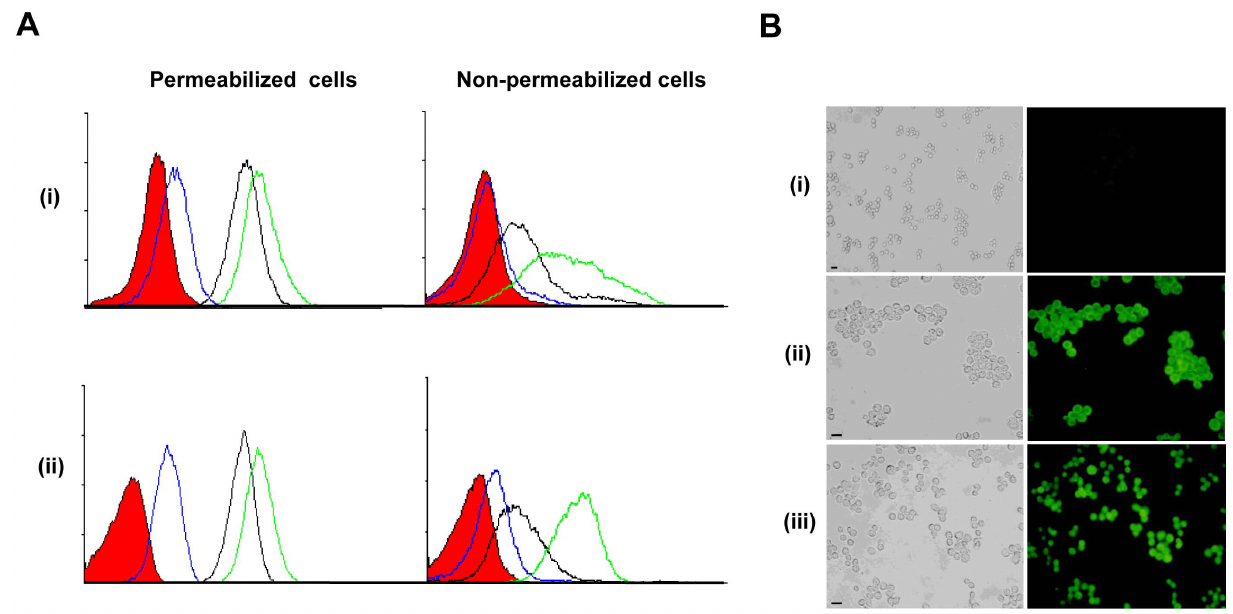
Figure 8. Reactivity of anti-hCG antibodies towards tumor cells. (A) Flow cytometric analysis on permeabilized and non-permeabilized (i) SP2/O and (ii) B16F10 cells using pooled antisera from b hCG-TT (black profiles) and b hCG-TT + MIP (green profiles) immunized mice; pre-immune sera (blue profiles) served as control. Filled red profiles: Secondary antibody controls. (B) Right panels: Immunofluorescence analysis on permeabilized COLO205 cells depicting reactivity of (i) pre-immune sera, (ii) antisera derived from b hCG-TT + MIP immunized mice and (iii) antisera derived from b hCG-TT immunized mice. Left panels: Corresponding phase contrast images. Bars=30 m m.